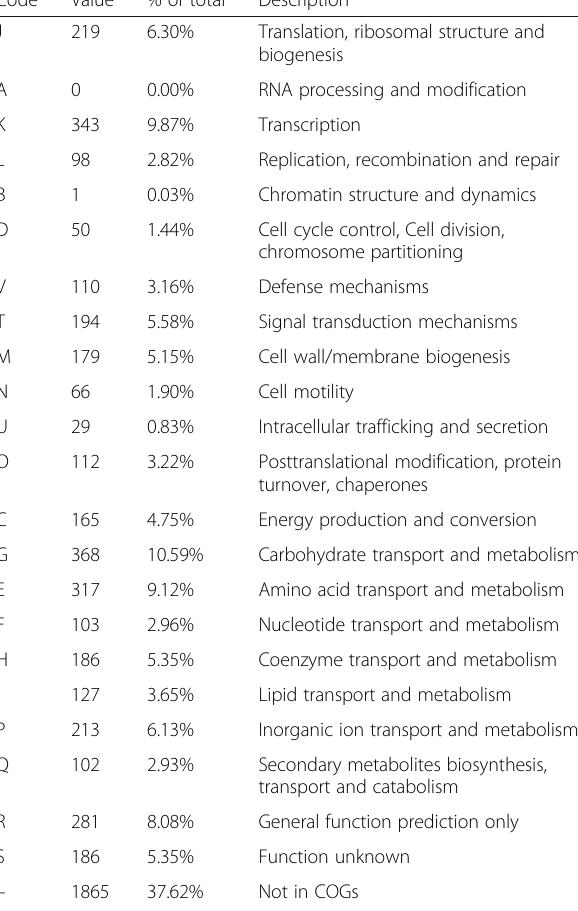
Table 5 Number of genes associated with general COG functional categories